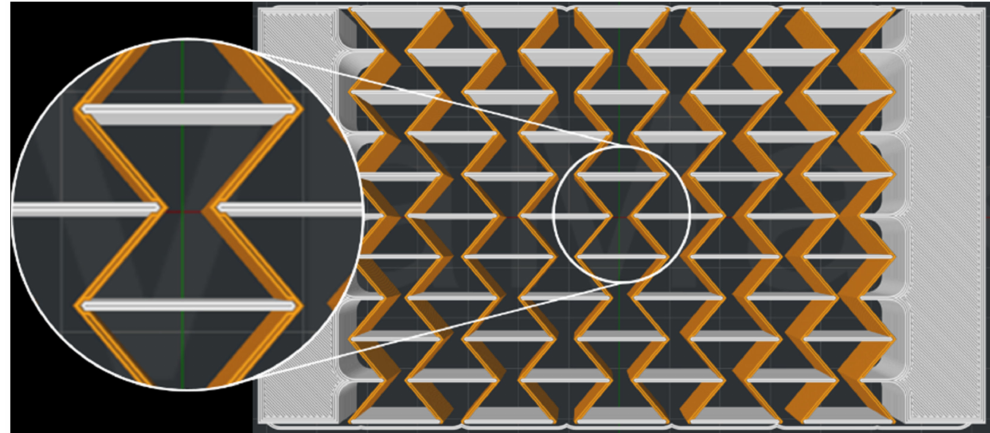
Figure 9. Schematic representation of a dual printed honeycomb structure.